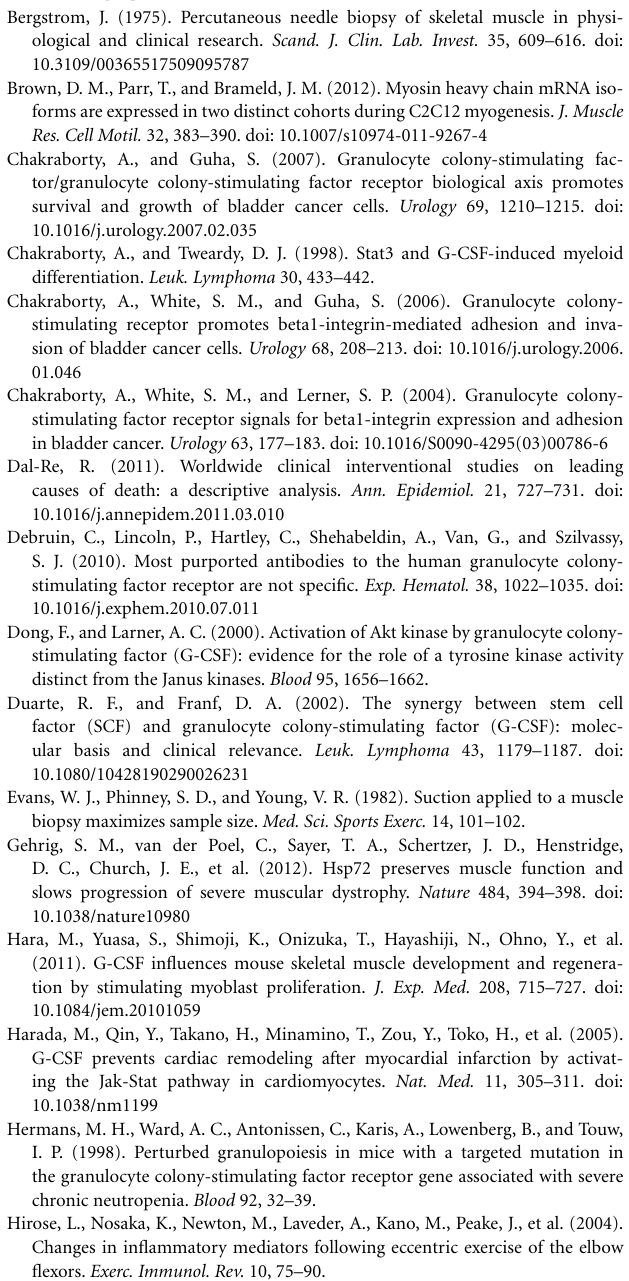
Supplementary Figure 2 | DAPI staining of proliferating C2C12 myoblast following G-CSF stimulation grown in 10% FBS. Representative images following DAPI staining of C2C12myoblastsfollowing 24, 48, 72, and 96h in DMEM + 10% FBS with the indicated concentration of G-CSF. A minimum of 10 images were obtained per sample ( n = 3). Supplementary Figure 3 | DAPI staining of proliferating C2C12 myoblasts following G-CSF treatment with serum depletion. Representative images following DAPI staining of C2C12myoblastsfollowing 24, 48, 72, and 96h in DMEM + 2% BSA with the indicated concentration of G-CSF. A minimum of 10 images were obtained per sample ( n =